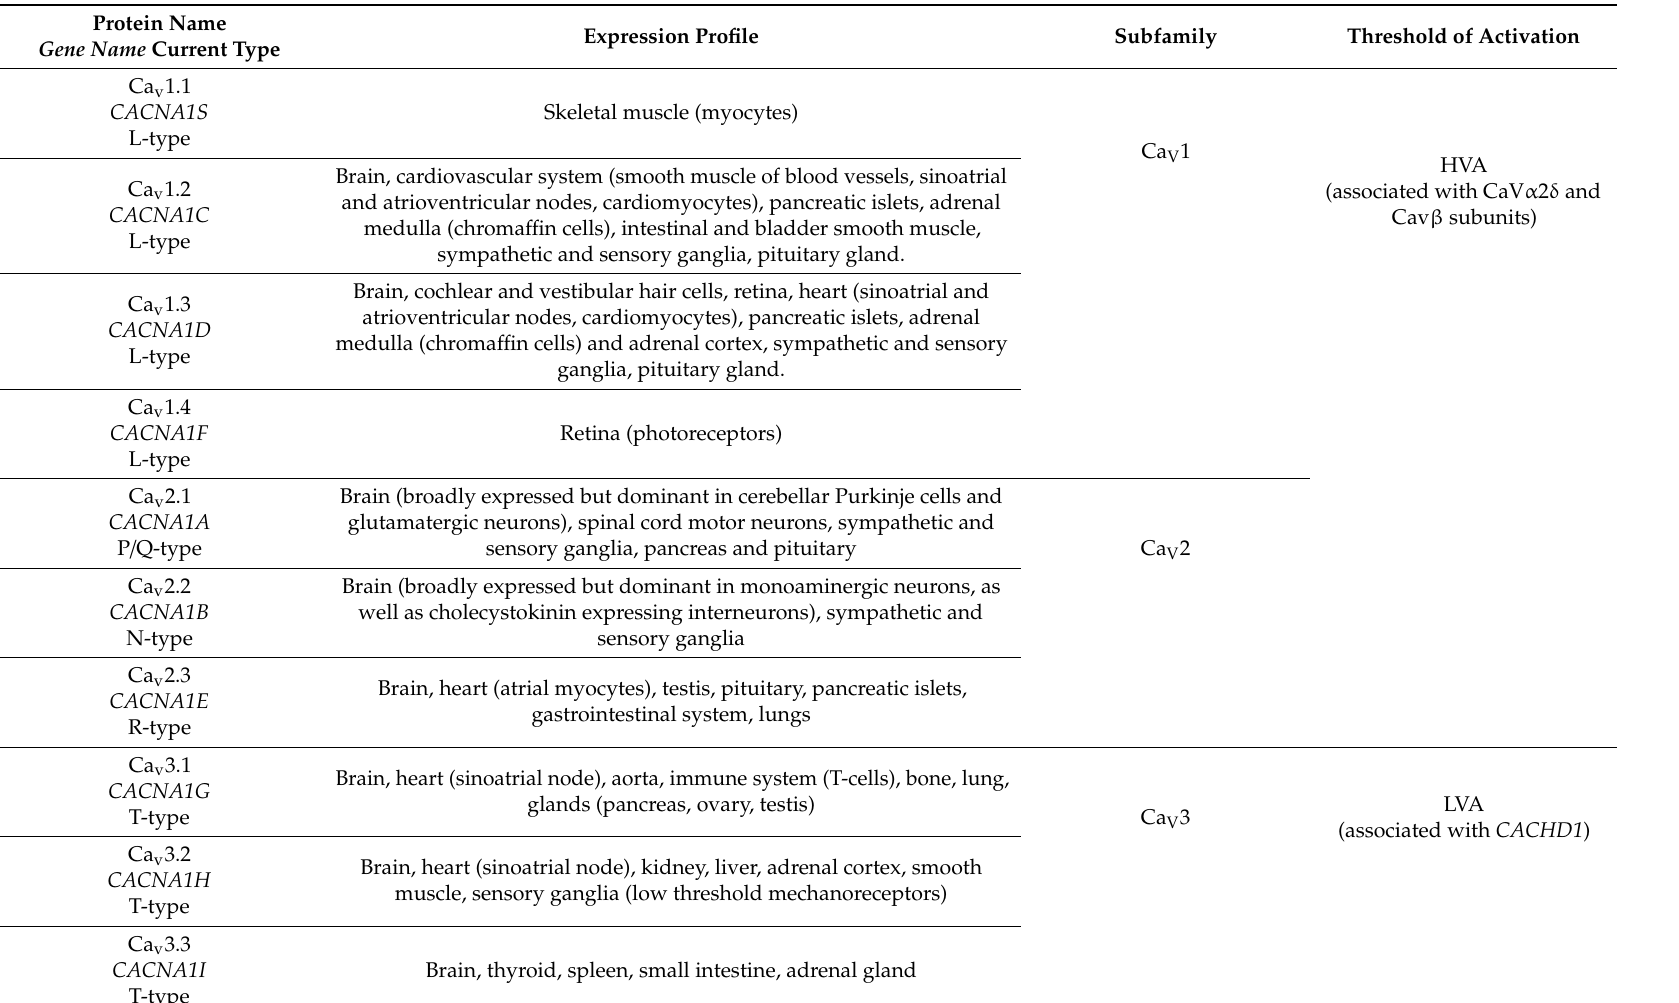
Table 1. Nomenclature and classification of voltage-gated calcium channels Ca V α 1 subunits based on sequence similarity and biophysical